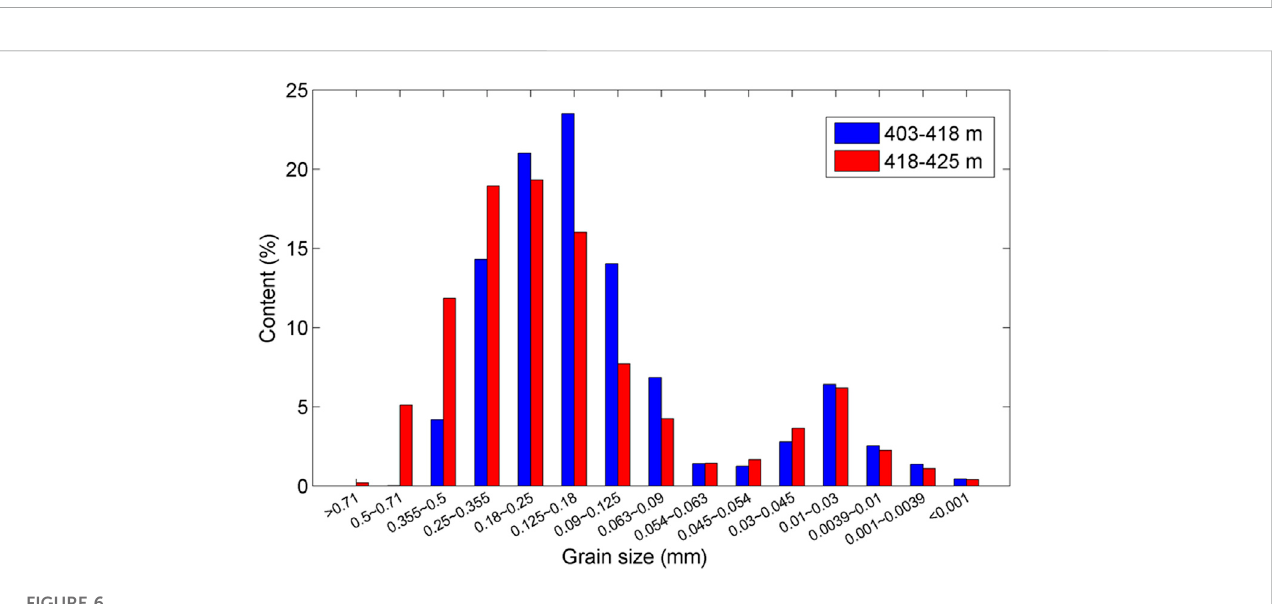
FIGURE 6 Statistical distribution of the grain